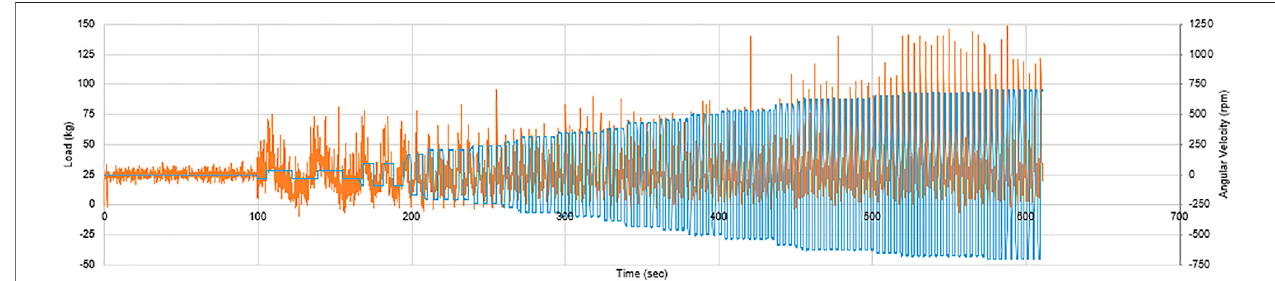
FIGURE 9 | Graph of experienced load and angular velocity during a voltage increase from zero to approximately 8